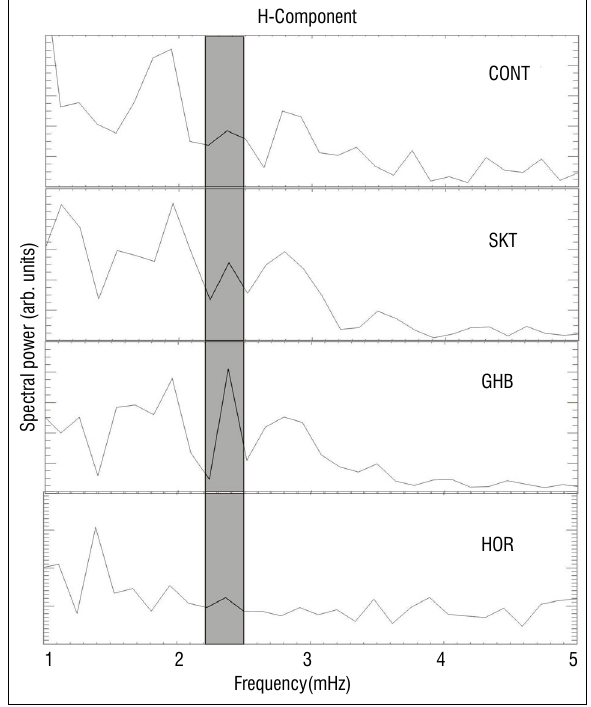
Corresponding spectral power for the magnetometer stations: Contwoyto (CONT), Sukkertoppen/Maniitsok (SKT), Nuuk/ Godthaab (GHB) and Hornsund (HOR).